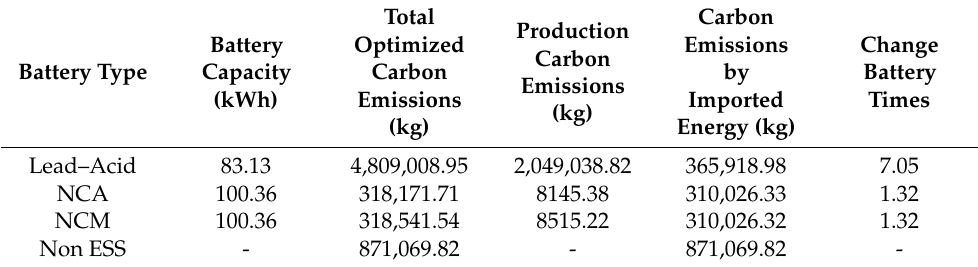
Table 4. Representative case studies’